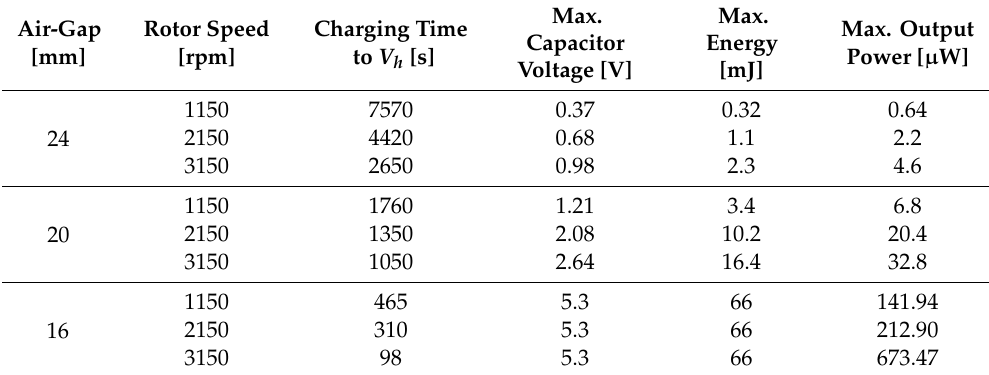
Table 4. Measured electric